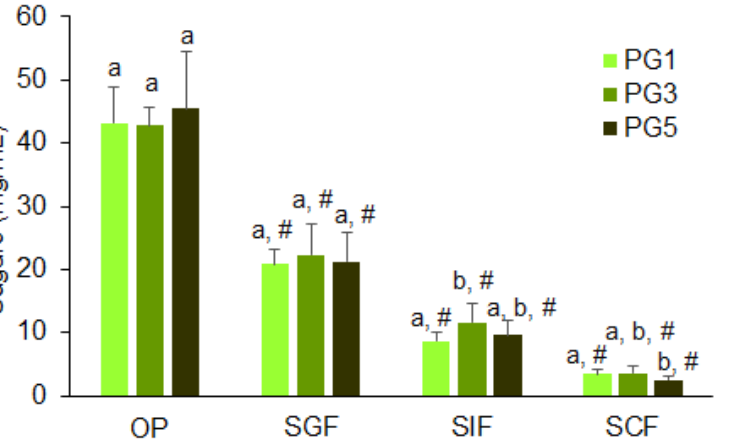
Figure 6. The amount of total sugars measured using phenol-sulfur method released from PGs during successive oral in vivo (OP) and gastrointestinal in vitro phases of digestion. SGF, SIF, and SCF—simulated gastric, intestinal, and colonic fluids, respectively. Means with standard deviations are given. Differences are significant ( p < 0.05) between means labeled with different lowercase letters (a and b); #—indicates significant differences vs. the previous phase ( n = 6, p < 0.05). Galacturonic acid was released predominantly after the digestion of PG1 in SIF and SCF (Figure 7A). Galacturonic acid was slightly released from PG5 during the initial stages of digestion (OP, SGF, and SIF) and in significant amounts during the SCF phase. The